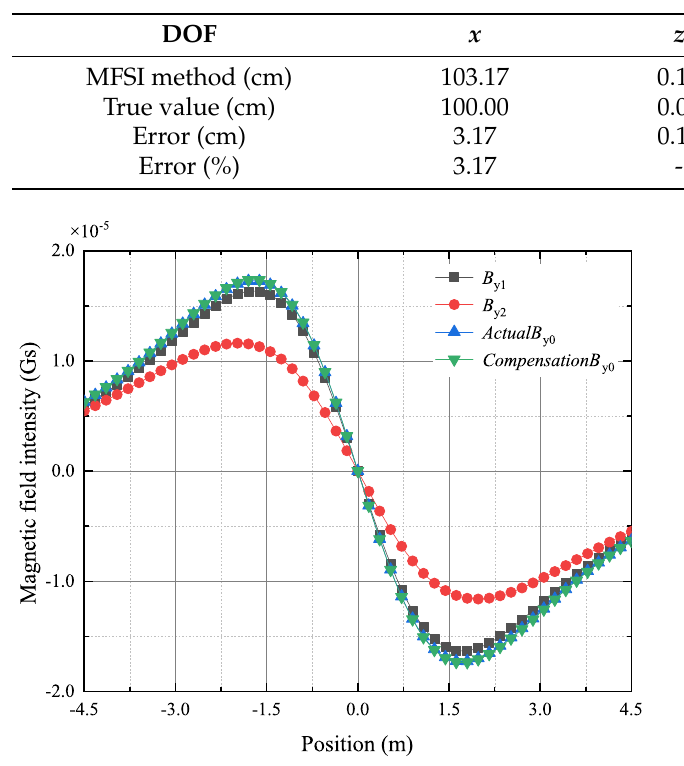
Figure 7. The radiated magnetic field of the transmitting coil in the lateral offset case. B y1 and B y2 are y -axis component of the magnetic field on the line ((1, 3, − 4.5), (1, 3, 4.5)) and line ((1, 3.5, − 4.5), (1, 3.5, 4.5)) in meter, respectively. CompensationB y0 is the compensated magnetic field by MFSI method, while ActualB y0 is the original magnetic field on the line ((1, 3, − 4.5), (1, 3, 4.5)) in